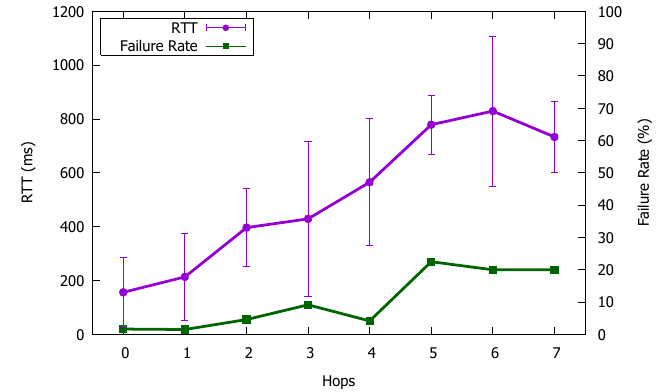
Figure 12. Results for each number of